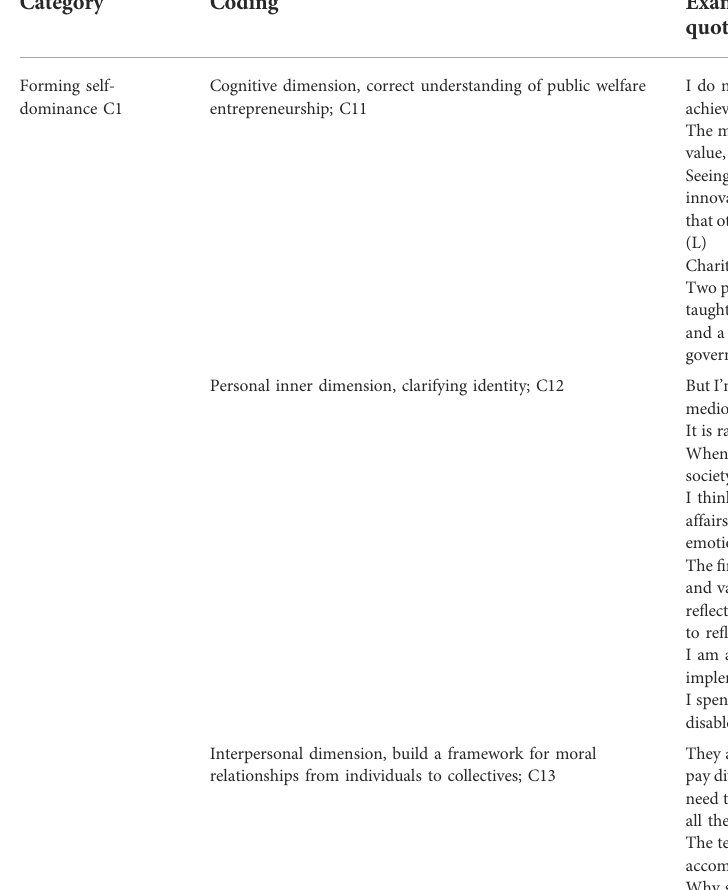
TABLE 5 Examples of typical statements and related categories in the stage of relation